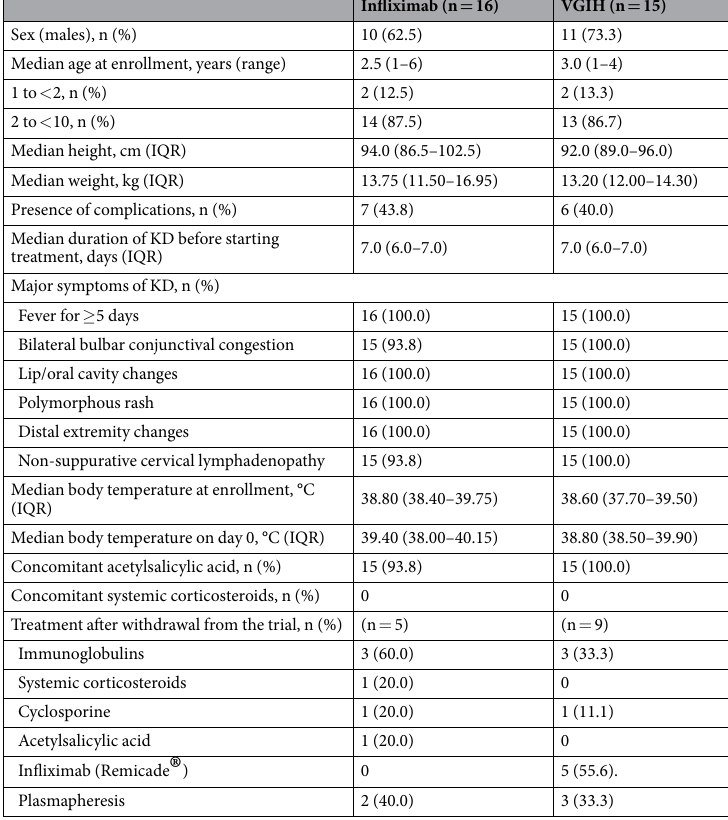
Table 1. Patient characteristics. KD, Kawasaki disease; IQR, interquartile range; VGIH, polyethylene glycol- treated human